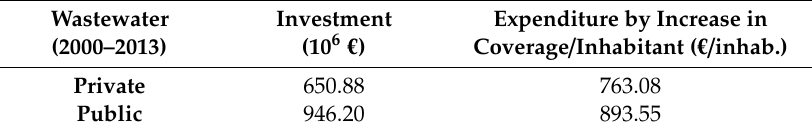
Table 3. Investments made and e ffi ciency of investments in wastewater